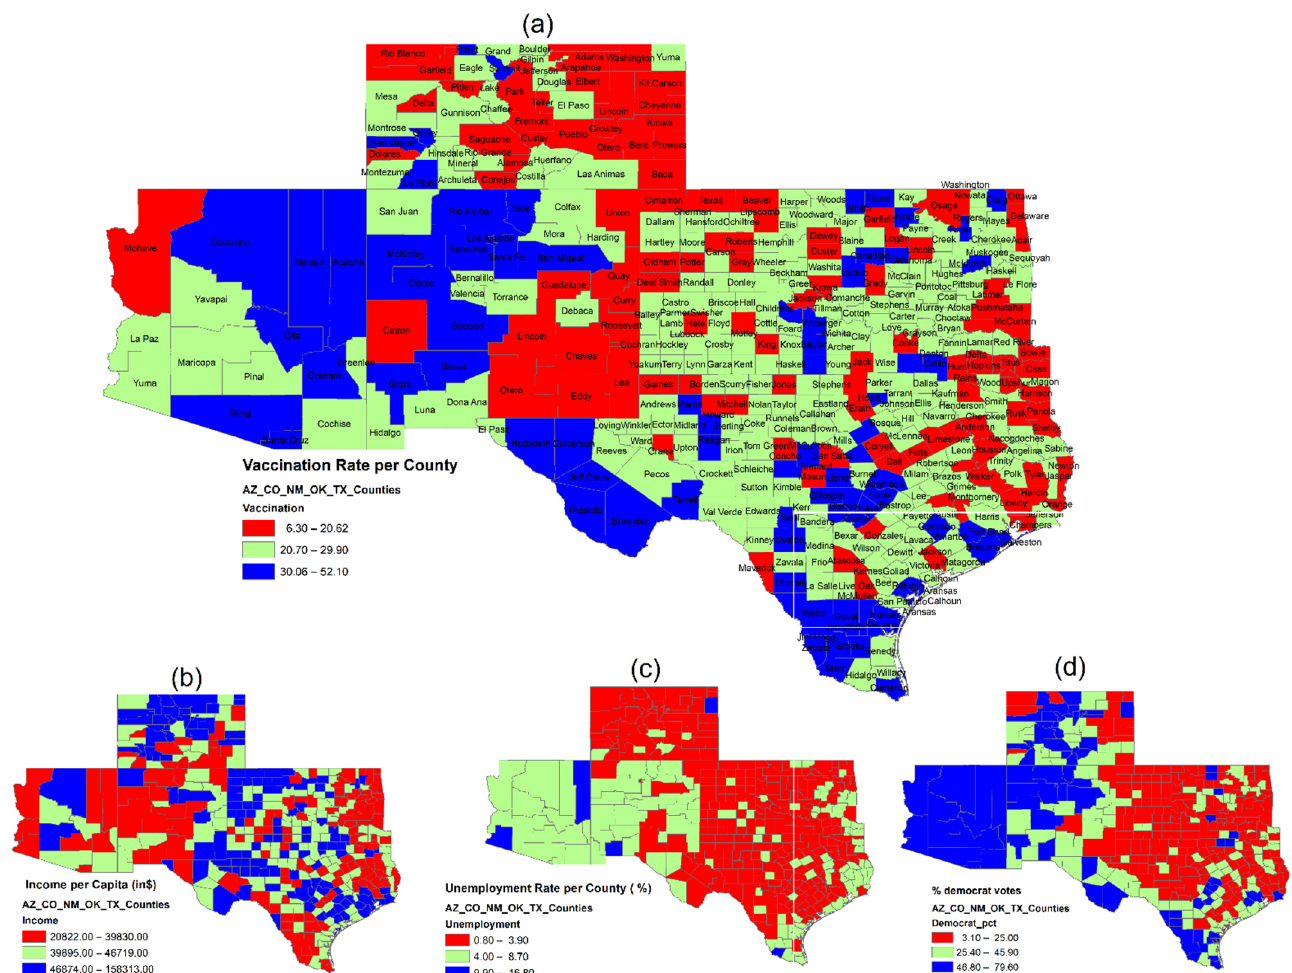
Figure 1. Geographic distribution of ( a ) COVID-19 vaccination rate as of 1 May 2021 and economic status, which is described by ( b ) income per capita; ( c ) unemployment rate; ( d ) political affiliation.